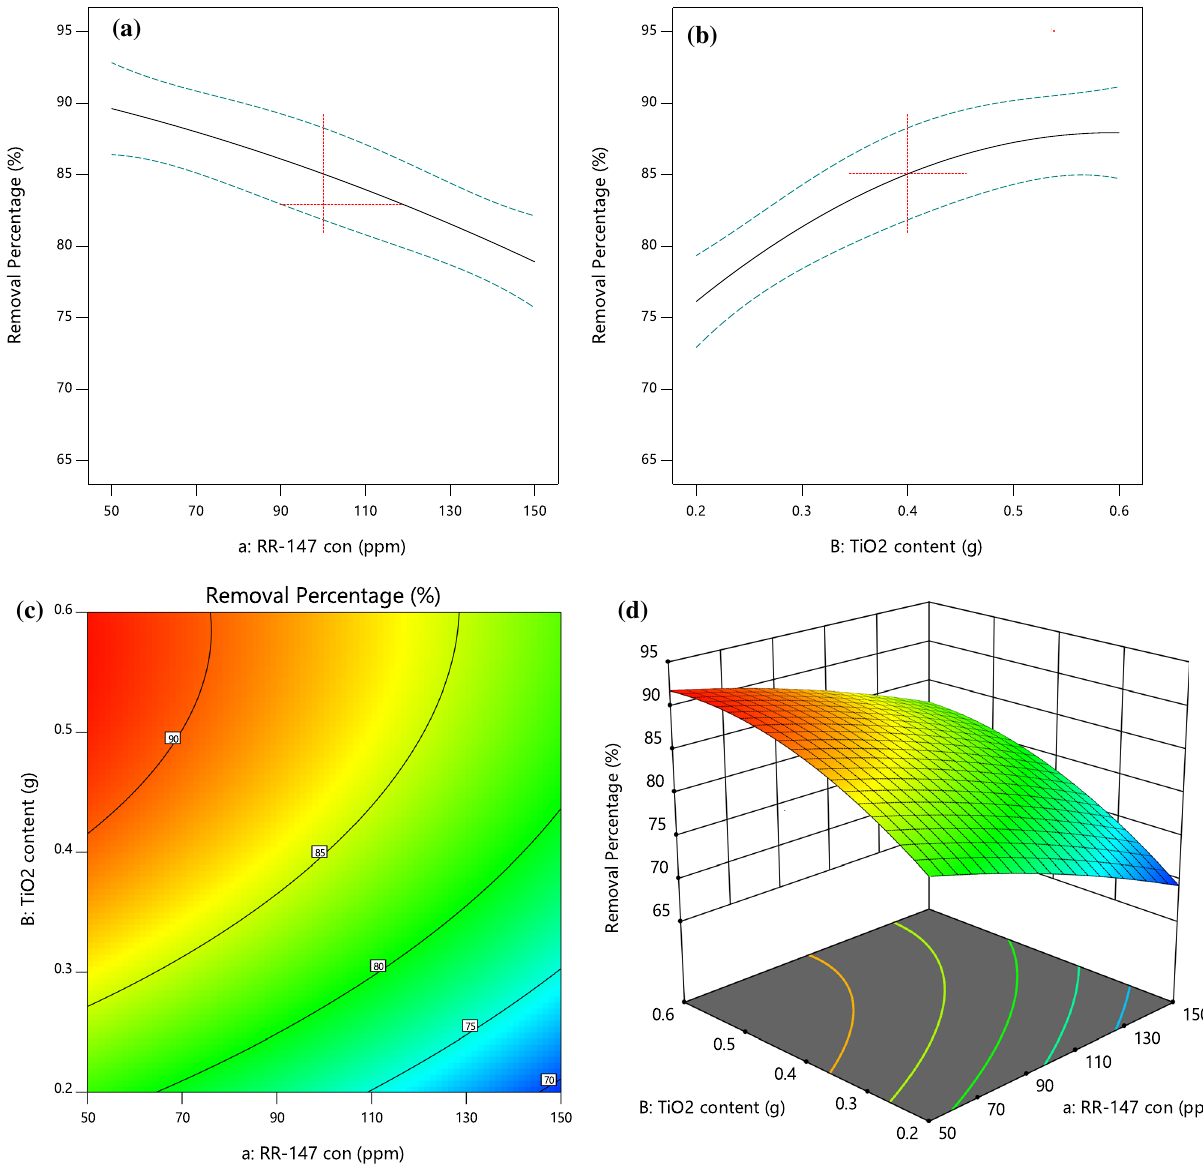
Fig. 8 Influence of various dye concentration a with different TiO plot according to RSM